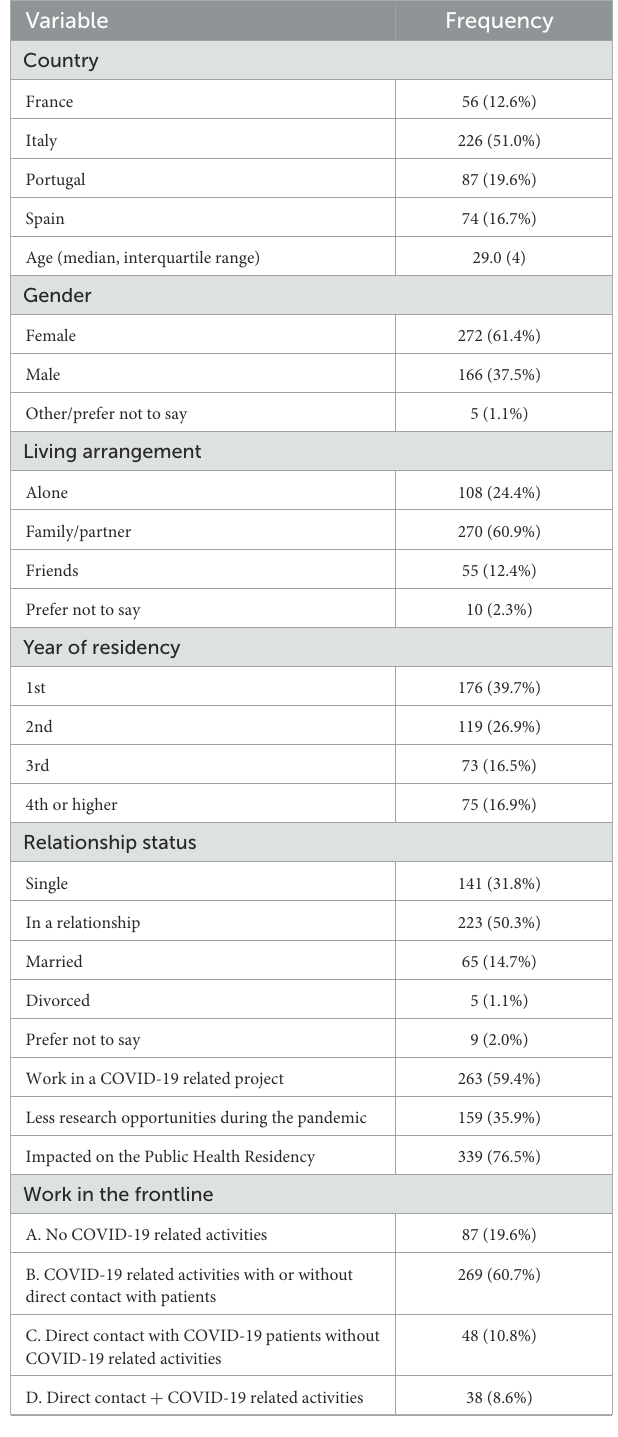
TABLE 1 Characteristics of the study population (Public Health Residents’ Mental Health, Europe,